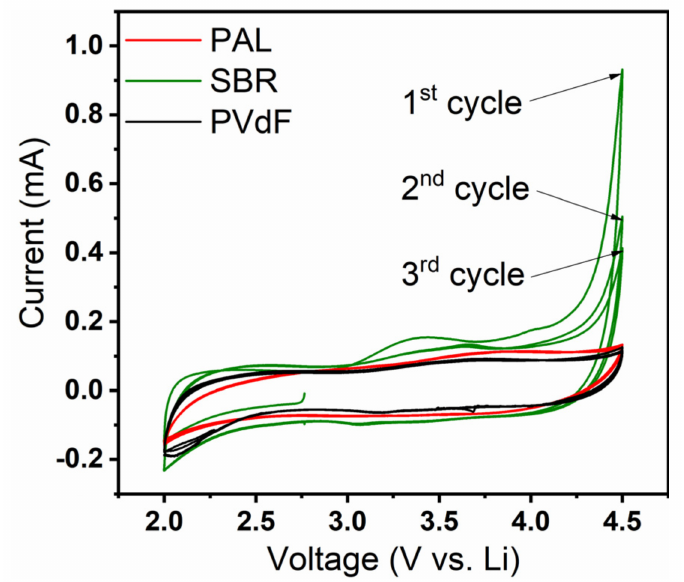
Figure 1. Cyclic voltammetry (CV) of the binder electrodes. The binder electrodes are composed of styrene-butadiene rubber (SBR), polyacrylate latex (PAL), or polyvinylidene fluoride (PVdF) with excess amounts of super-p (SP) conducting